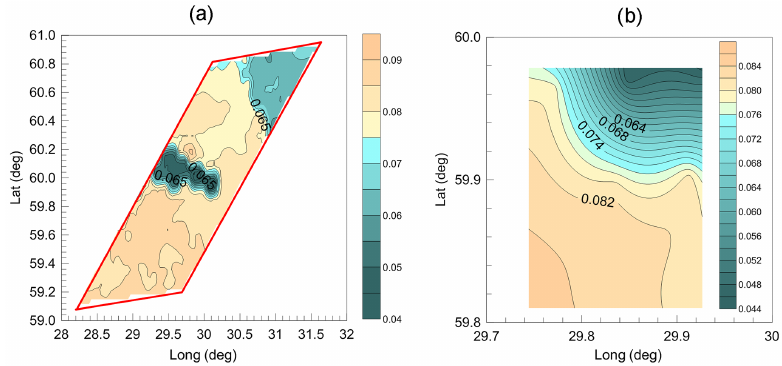
Figure 2. The maps of the mean LWP values (kgm − 2 , colour scale) calculated for the large terrain (a) and small terrain (b) and for the